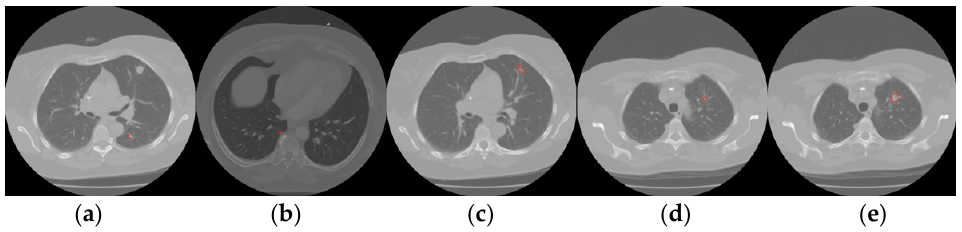
Figure 3. Samples of malignant nodules (red) on CT scans of the LIDC, sorted via malignancy annotations from radiologists: ( a ) highly unlikely, ( b ) moderately unlikely, ( c ) indeterminate, ( d ) moderately suspicious, and ( e ) highly suspicious.